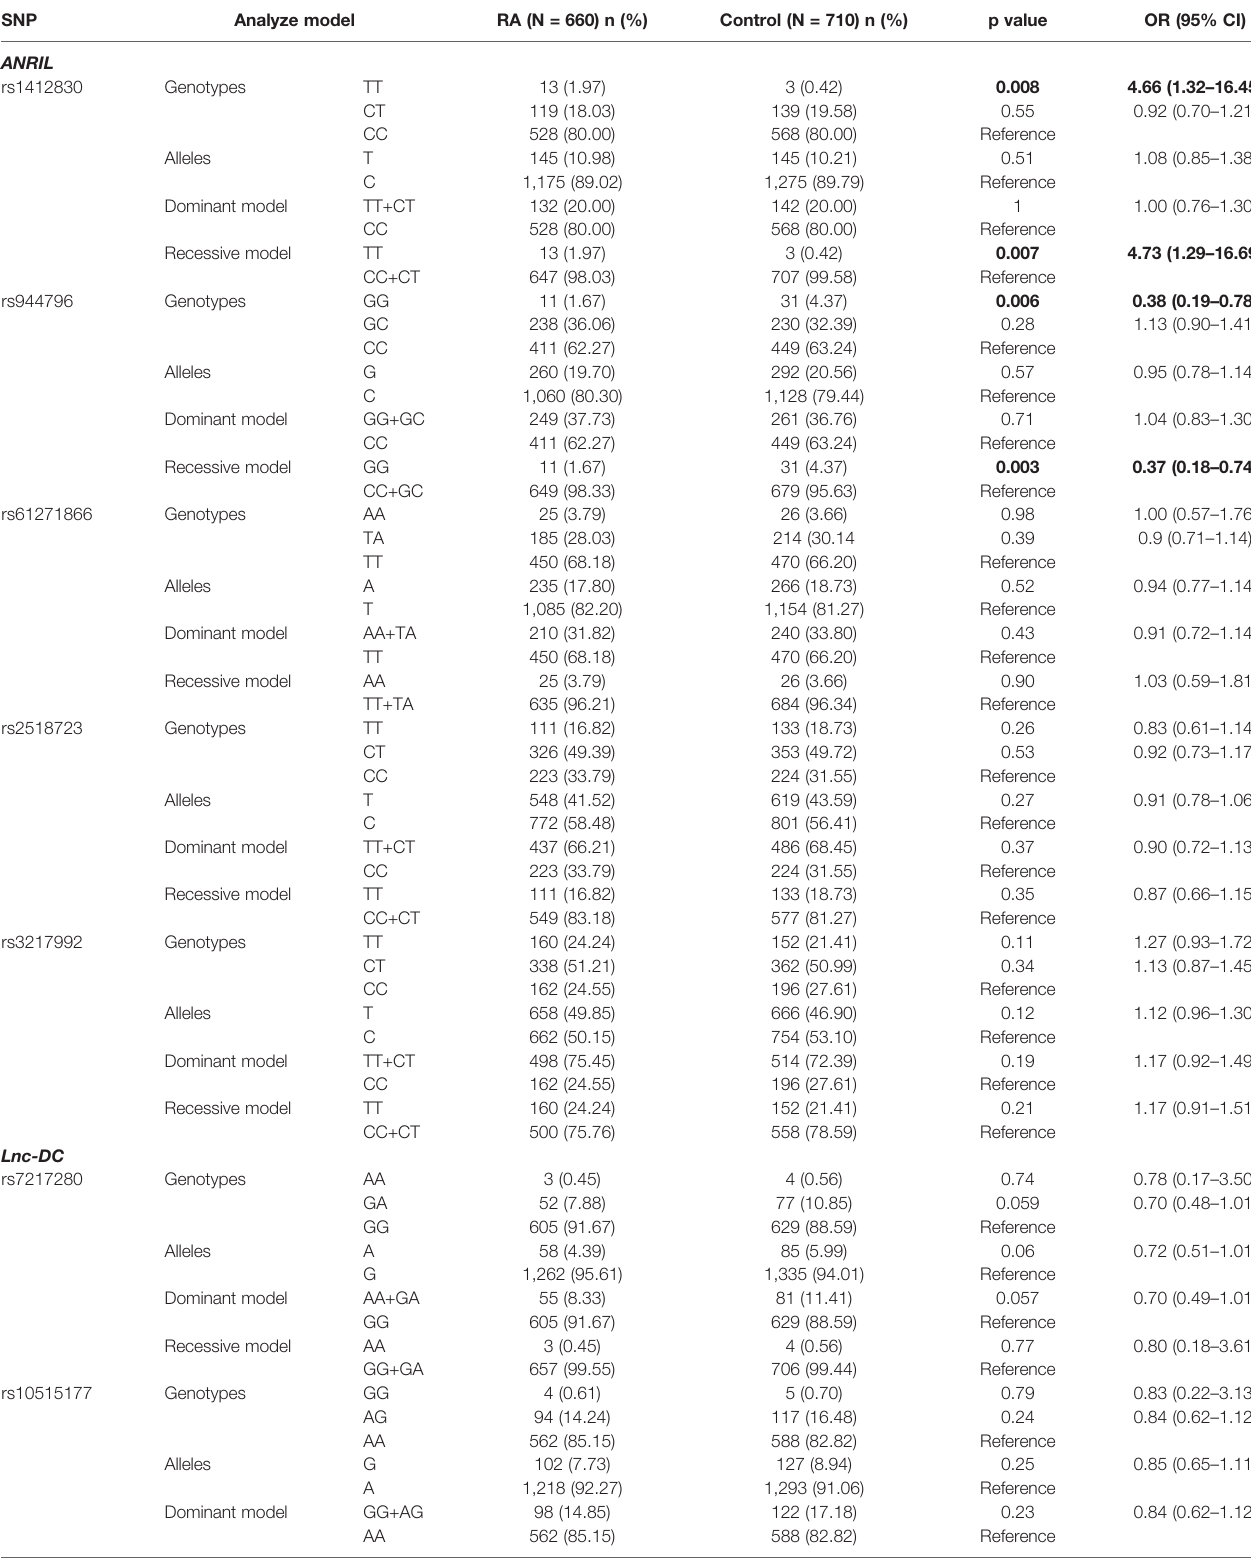
TABLE 1 | Correction: Genotypes and allele frequencies of lncRNA gene polymorphisms in RA patients and normal controls.